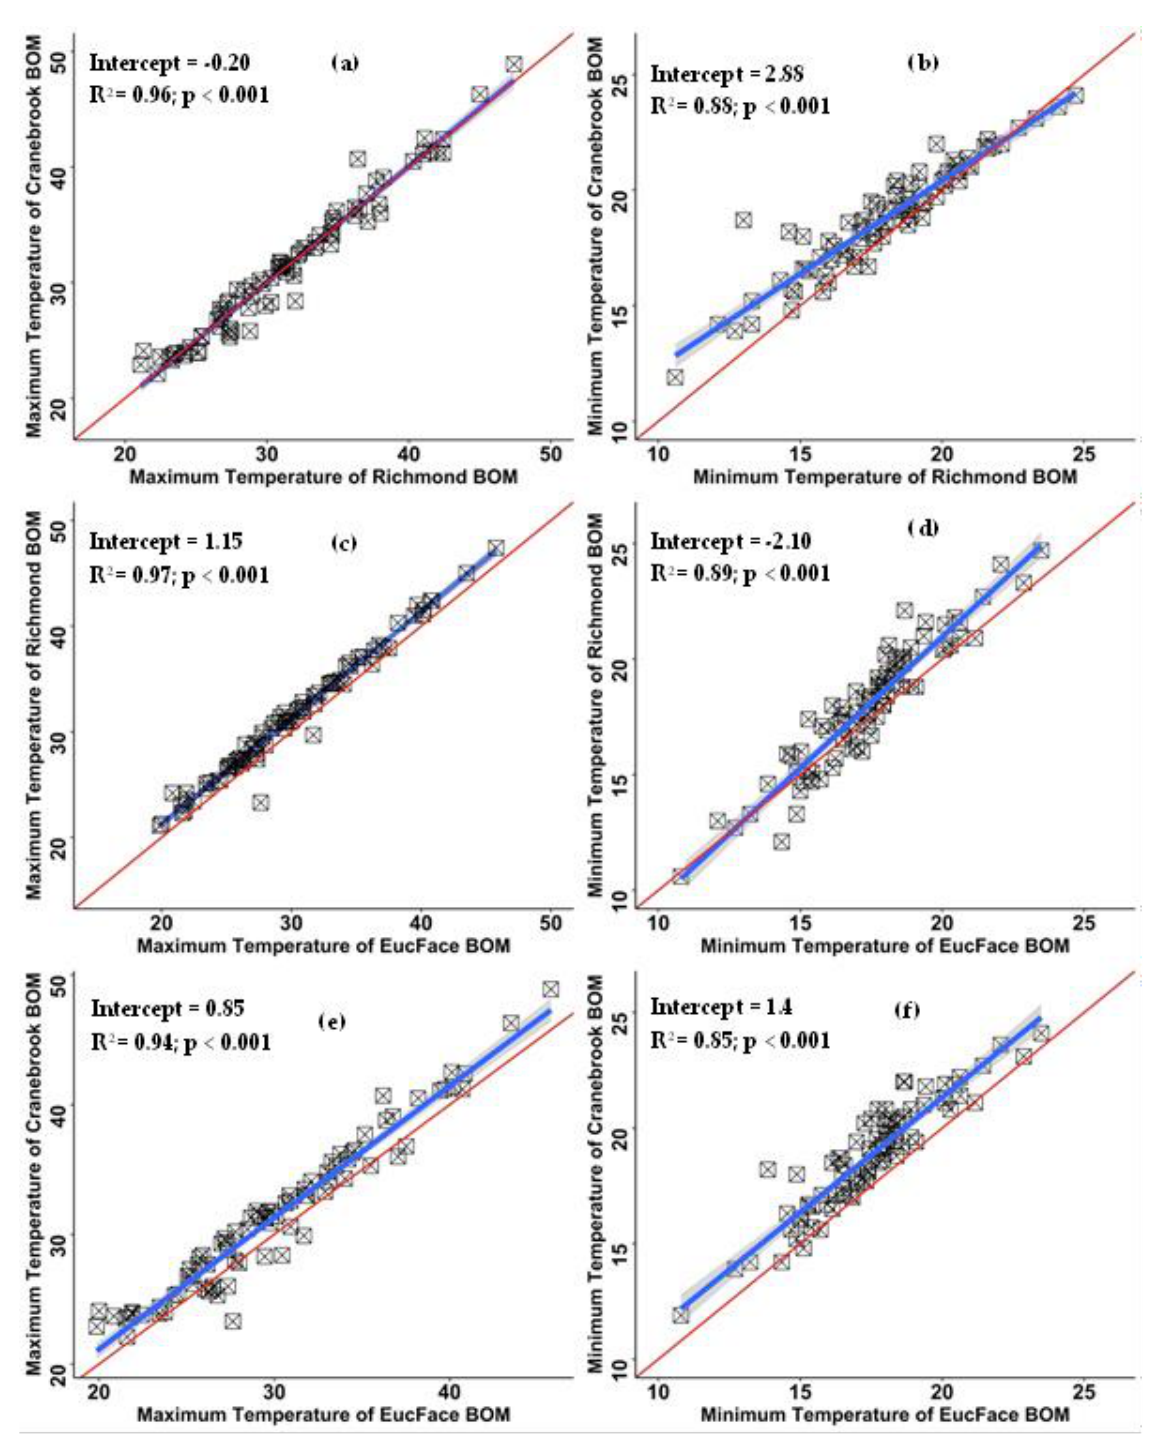
Figure 2. Correlation between air temperatures recorded by three weather stations (EucFace, Rich- mond and Cranebrook); ( a , b ) maximum and minimum temperatures of Richmond BOM vs maximum and minimum temperatures from the EucFace meteorological station; ( c , d ) maximum and minimum temperatures of Richmond BOM vs maximum and minimum temperatures of Cranebrook BOM; ( e , f ) maximum and minimum temperatures of Cranebrook BOM vs maximum and minimum temperatures of the EucFace meteorological station .